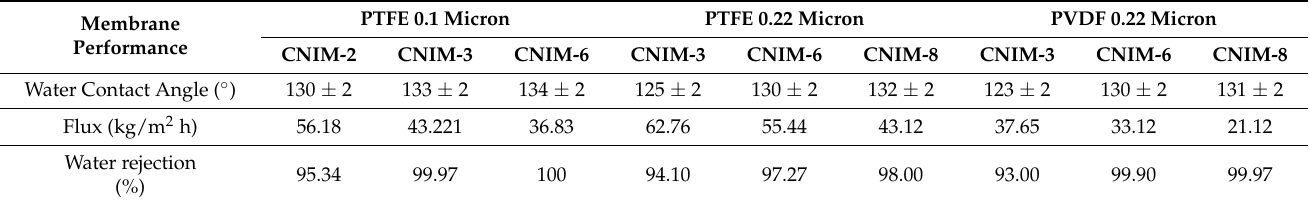
Table 2. Effect of CNTs concentration on membrane